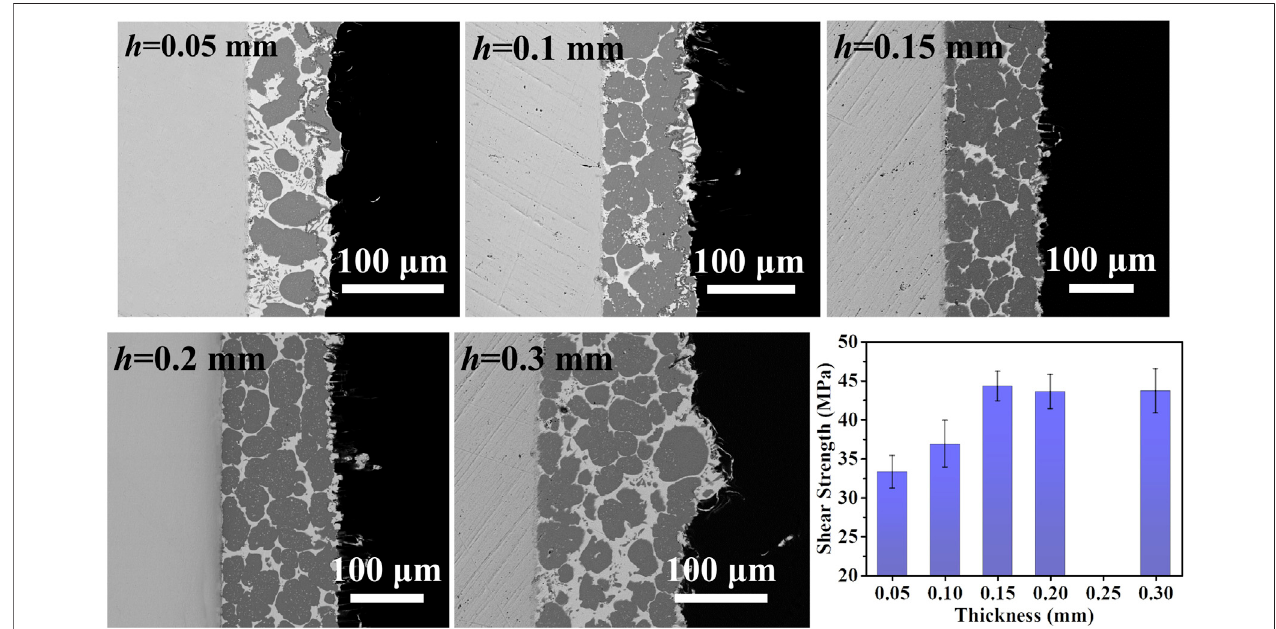
FIGURE 6 | SEM images and mechanical performance of C/C-Nb joints brazed using different G-Cu f interlayers differing in thickness.